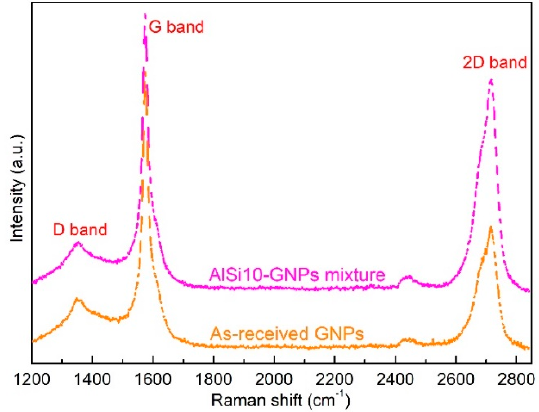
Figure 2. Raman spectra of as-received graphene nanoplatelets and AlSi10Mg-GNPs nanocomposite powder after mixing.